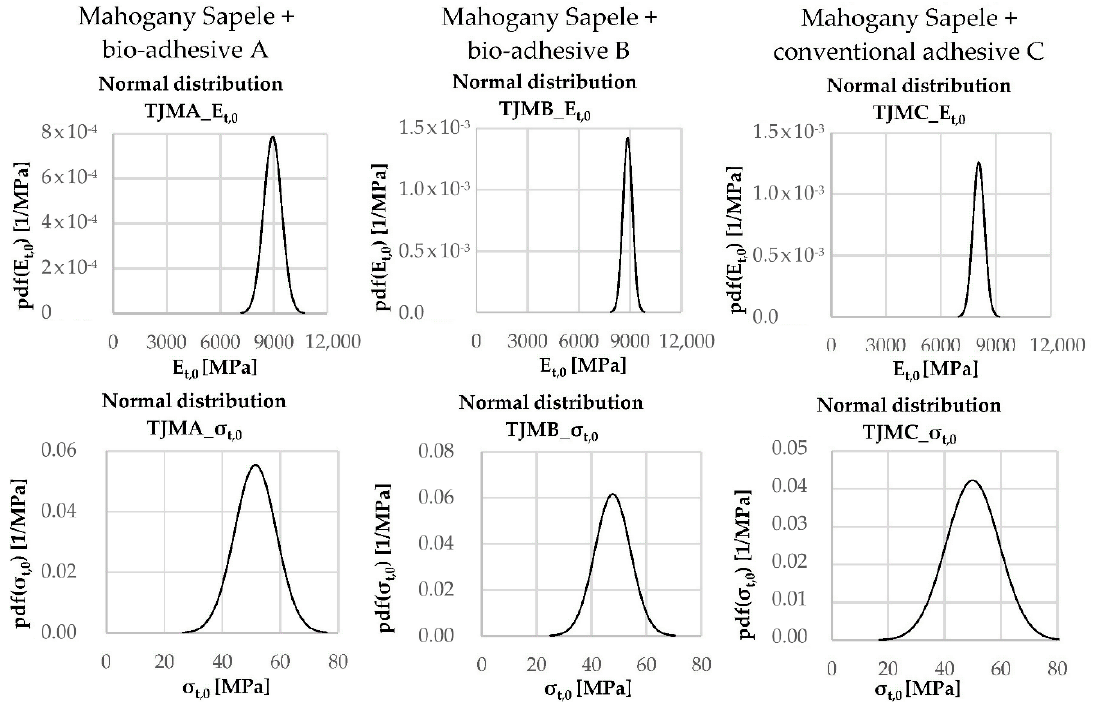
Figure A2. Statistical analysis for tensile properties on Mahogany Sapele scarf-joint specimens.